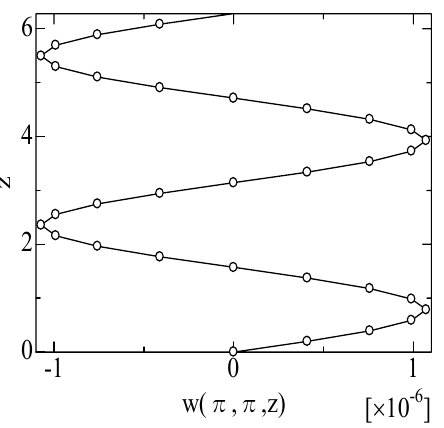
Fig. 7 Distribution of velocity w at x = ( π , π ,z).